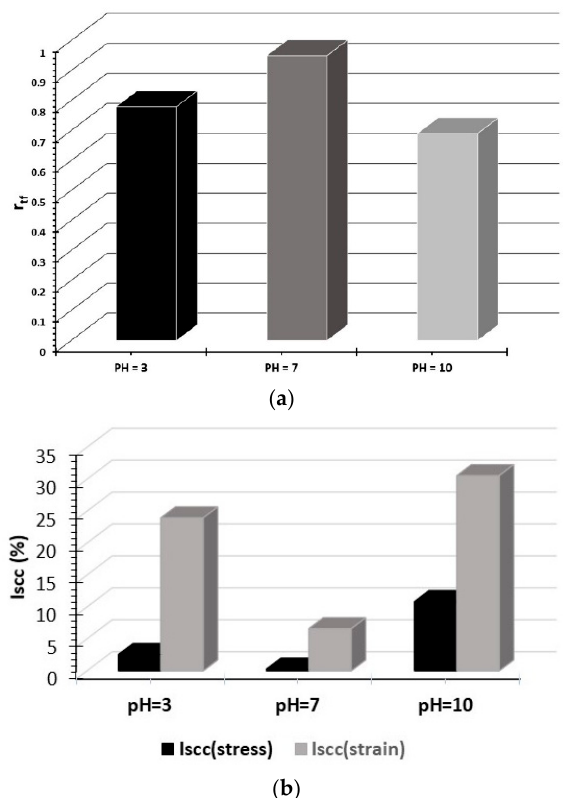
Figure 9. Effect of pH of 0.3 M NaCl solution on ( a ) the ratio of time-to-fracture ( r tf ) index and ( b ) the I SCC susceptibility index of T6 treated 6082 aluminum alloy.